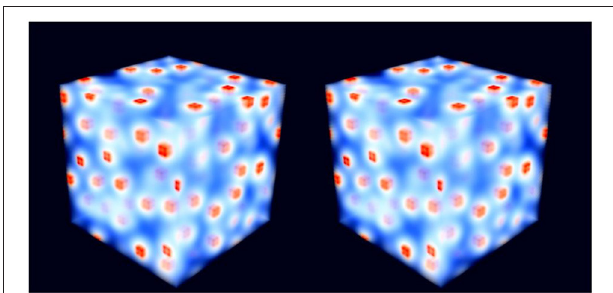
FIGURE 12 | An example of the system simulated by Bergsma et al. [130]. Dark red cubes indicate nodes (whose cores are shown with a slightly lighter red color). Due to steric repulsion, polymer molecules push each other away from the node, this drags anchoring groups outside the core, and therefore the density within the core decreases. Figure reprinted with permission from Bergsma et al. [130]. Notice to readers: further permissions related to the material excerpted should be directed to the